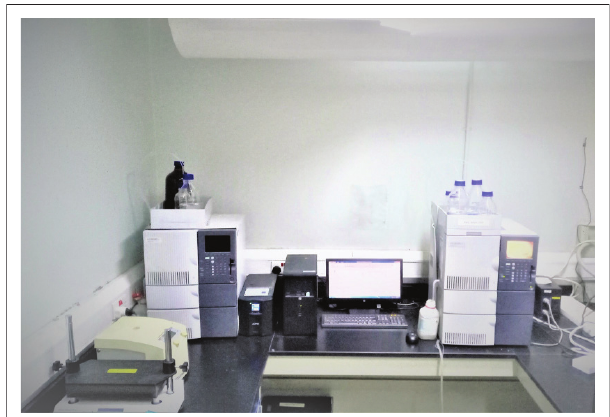
FIGURE 1: High-performance liquid chromatography-ultraviolet detection machines installed in the clinical pharmacology laboratory at the Infectious Diseases Institute, Makerere University College of Health Sciences, Kampala, Uganda between 2007 and